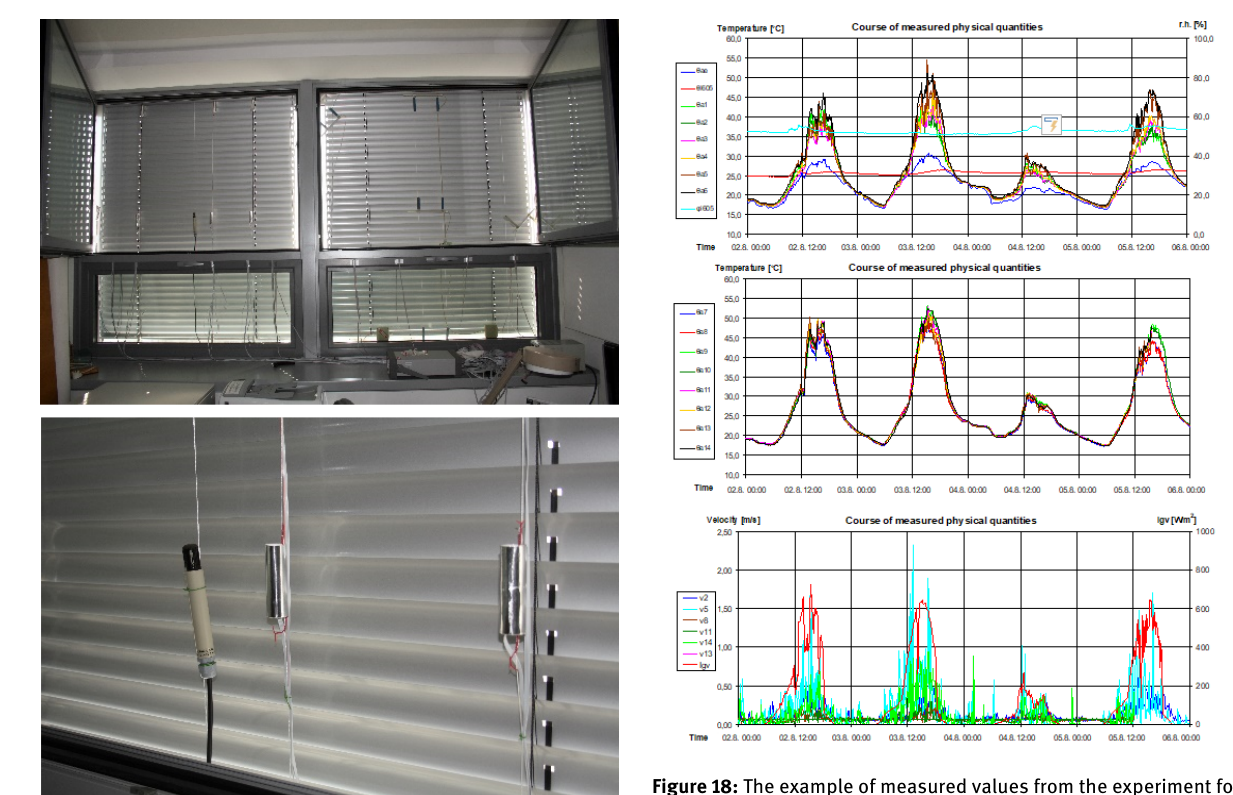
Figure 18: The example of measured values from the experiment for the typical period of nice warm